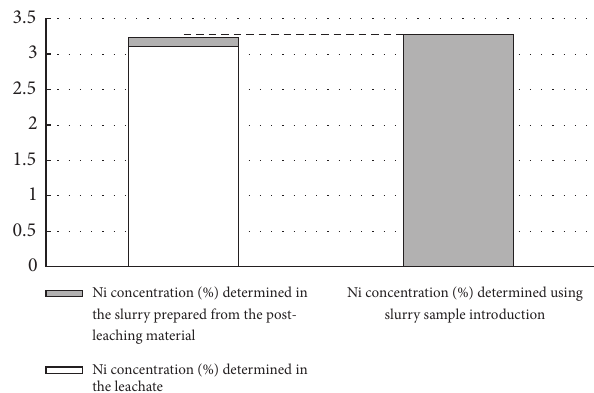
Figure 3: Mass balance of Ni in leaching studies (leaching medi- um—5% HNO 3